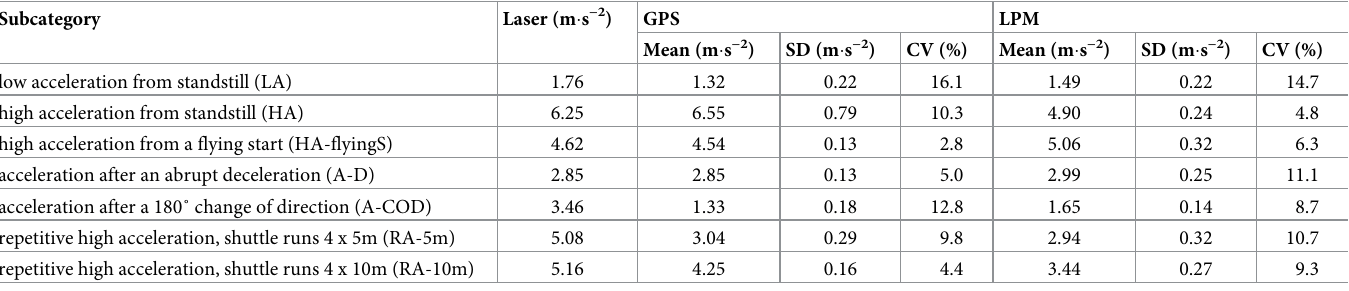
Table 2. Means and between-device standard deviations (SDs) of maximal acceleration (a max ) during different team sport-specific actions measured with a GPS and an LPM system and the mean of a max measured with laser.